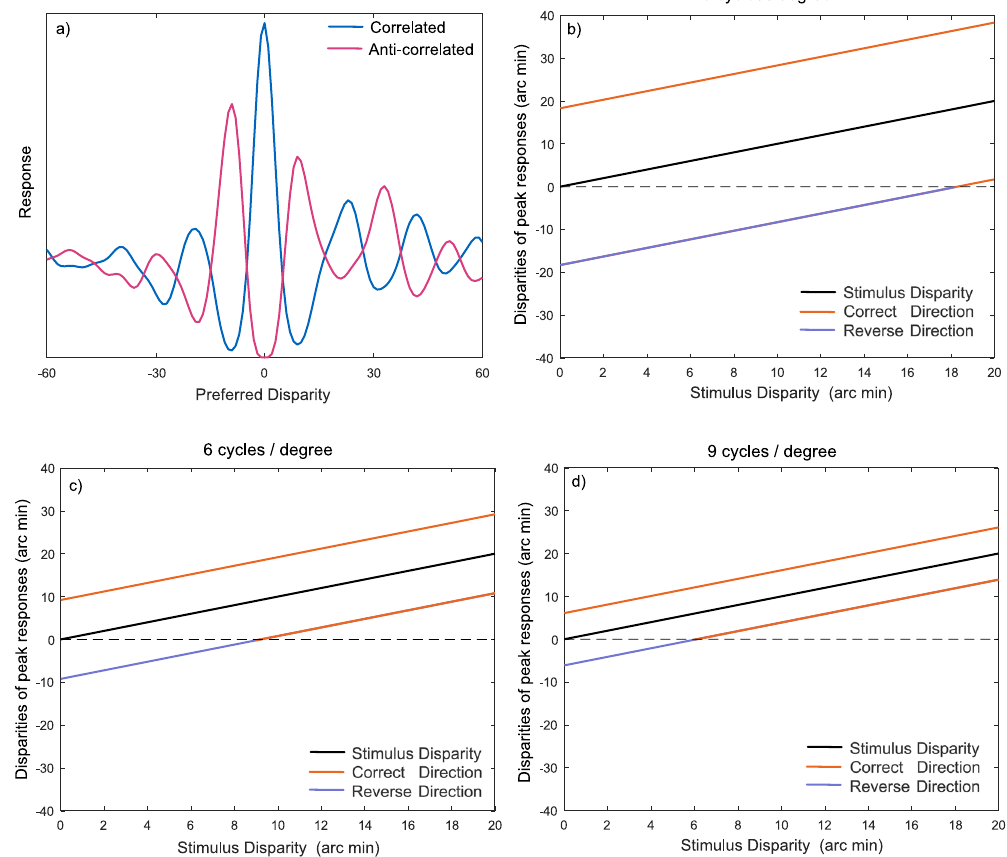
Figure 3. ( a ) An inverted disparity tuning function in response to an anti-correlated stereogram. ( b – d ) This produces peak responses that are offset from the tuning of the filter for correlated stimuli, which can signal the opposite sign of disparity to that of the neuron’s preferred disparity. The sign of this false peak depends on the tuning frequency of the filter and the stimulus disparity. Each plot shows the disparities of the peak responses to anti-correlated stimuli, for a filter that is tuned to the same disparity as the stimulus. Two peaks are plotted, one at a more crossed disparity, and one at a more uncrossed disparity, as indicated in ( a ). Responses are plotted as a function of disparity, averaged over 1000 Gaussian random noise stimuli. Individual plots show results for three different spatial frequencies. Depending on the combination of the stimulus disparity and the spatial frequency tuning of the filter, the two peaks either both signal forward-depth, or signal conflicting directions of